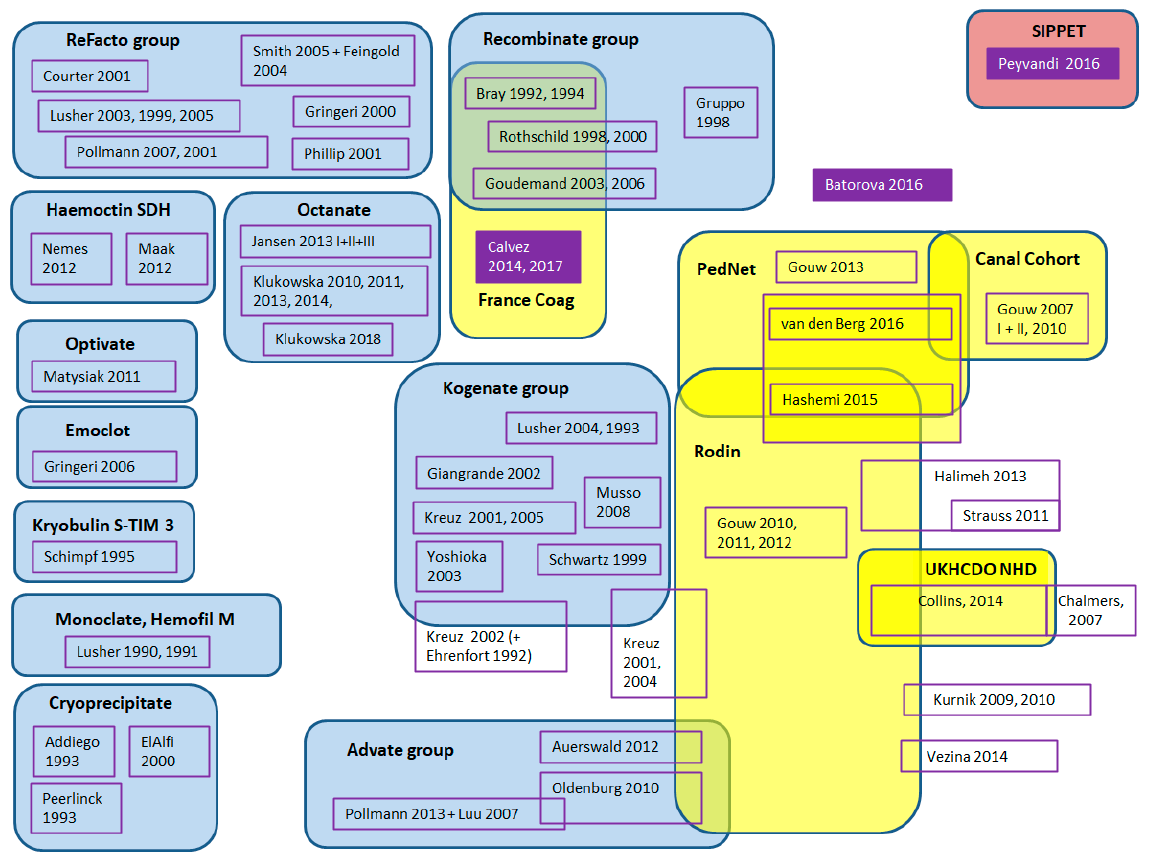
Figure 4. Risk of overlap of individual studies—Studies evaluating a single factor concentrate are summarised under the name of the factor concentrate in blue boxes. Studies originating from registry data are presented in yellow boxes and prospective trials in pink boxes. The three remaining relevant studies following the parameters demanded in the ClinGL are shown in purple.